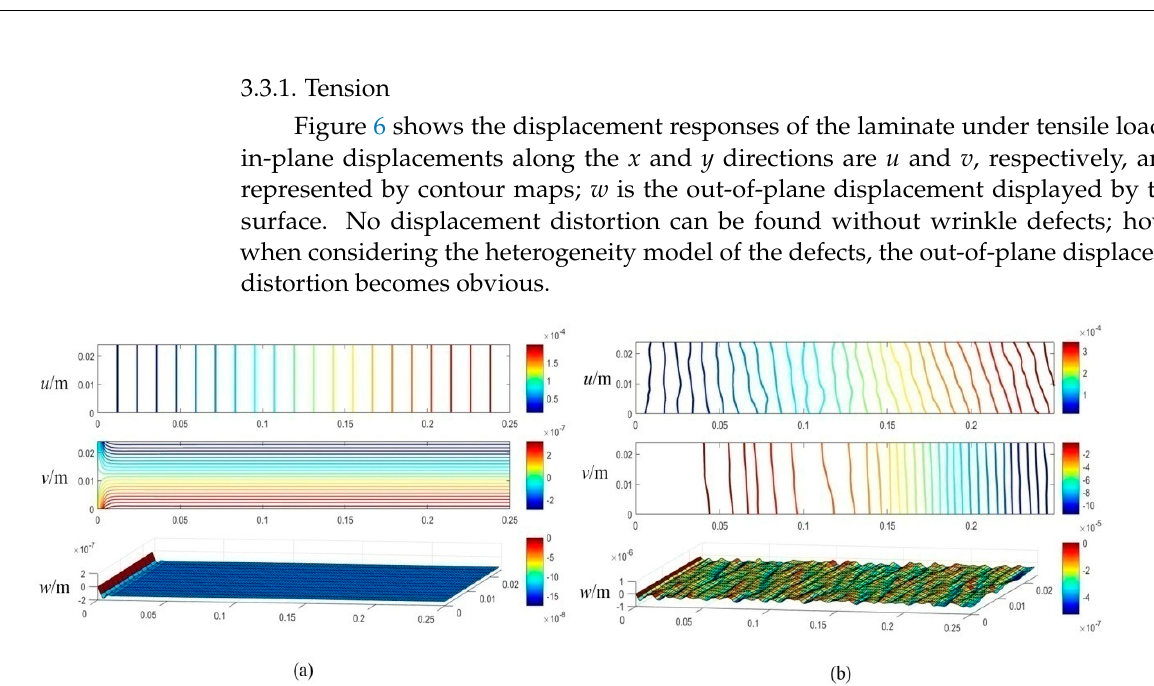
Table 1. Mechanical properties of orthotropic laminate.